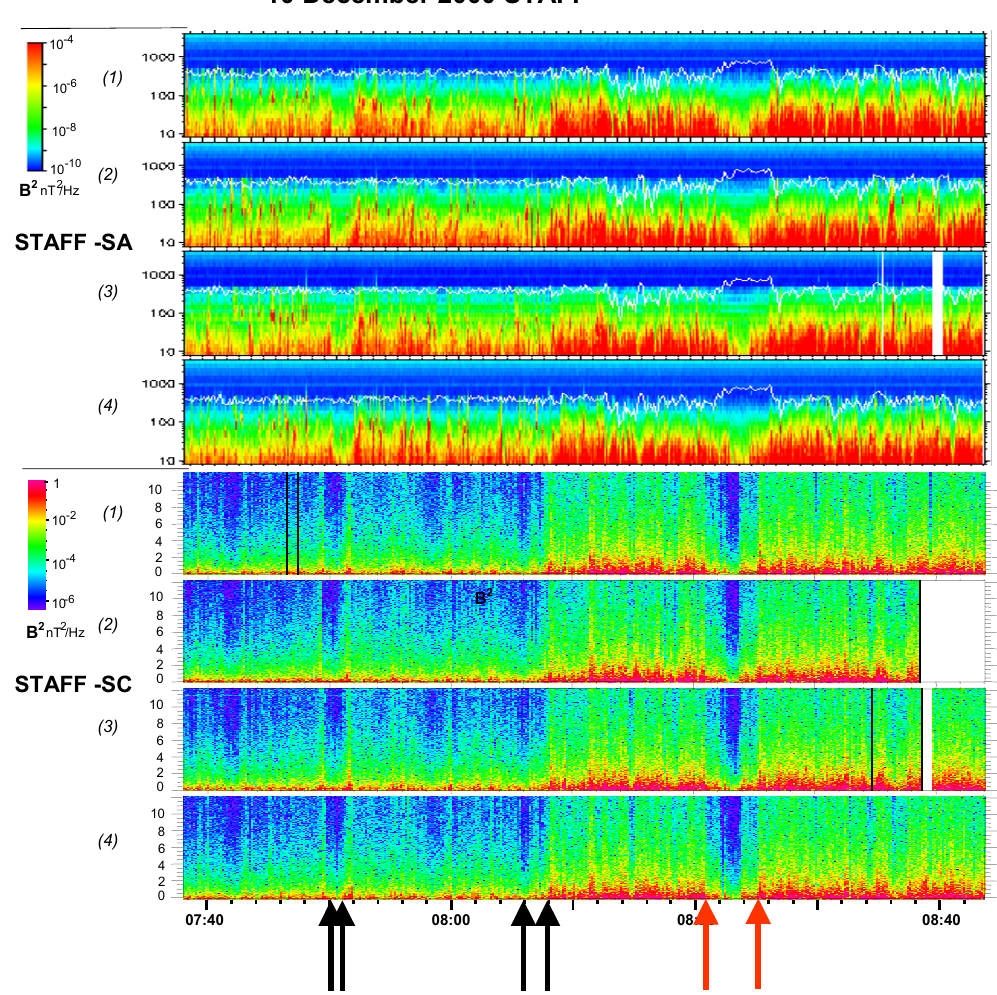
Figure 1 Fig. 1. Colour spectrogram of the STAFF data (the horizontal scale is time, the vertical scale is frequency in Hz). The four lowest panels show the STAFF-SC part, below 10Hz. The four top panels show the STAFF-SA high frequency band (10Hz–4kHz). The thin white line superimposed on the spectrograms is the electron gyro-frequency as deduced from FGM magnetic field. Many magnetopause crossings can be identified: they are identified by arrows on the plot. Red arrows show the two crossings studied in this